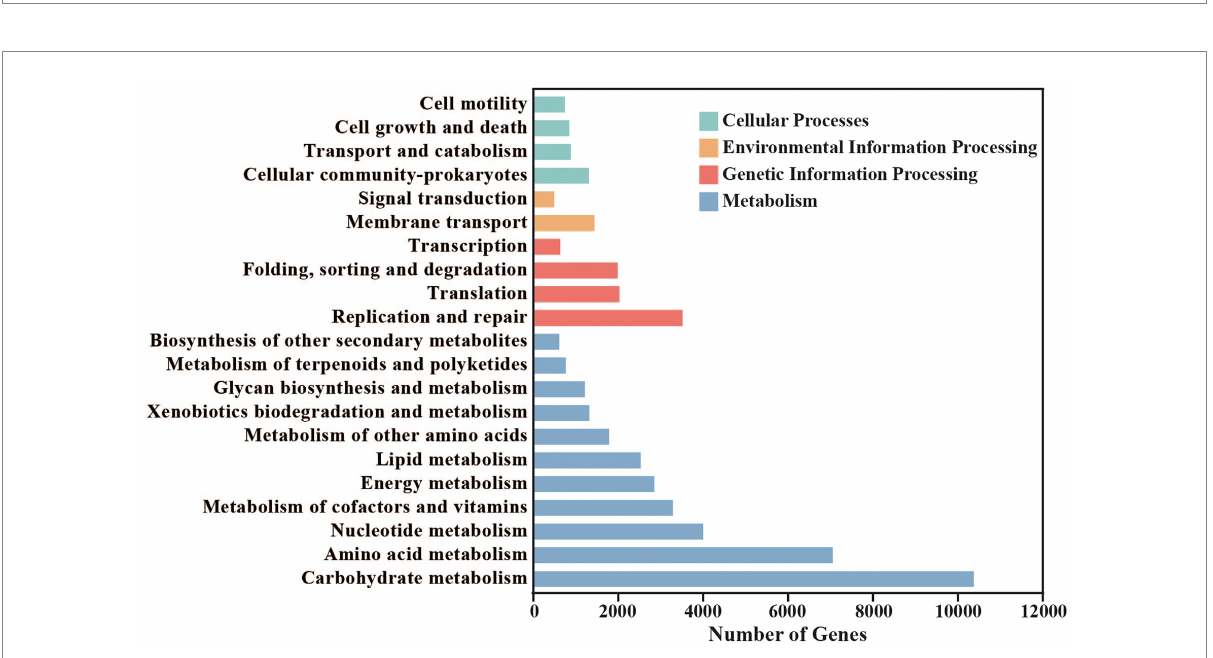
FIGURE 3 Statistics of Kyoto Encyclopedia of Genes and Genomes (KEGG) metabolic pathway in red vinasse